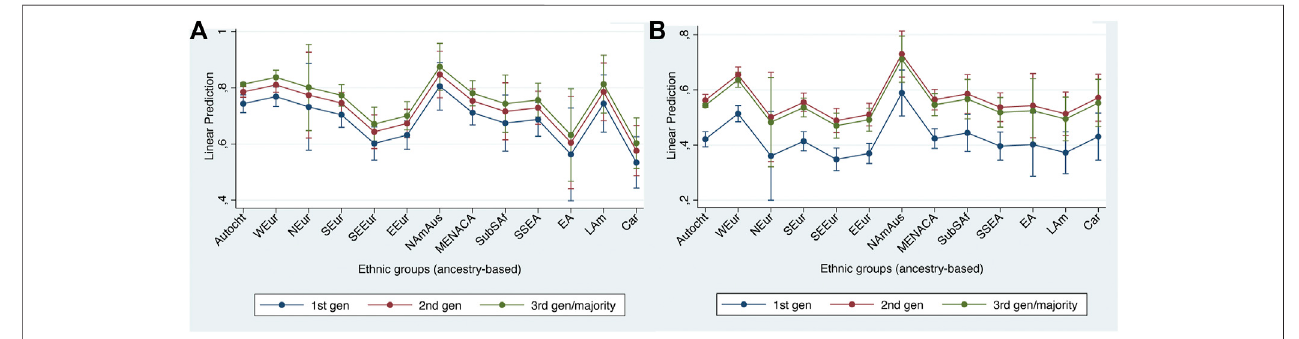
FIGURE 4 | Adjusted predictions at representative values for political integration indicators with 95% con fi dence intervals. (A) Voting; (B) non-electoral participation.